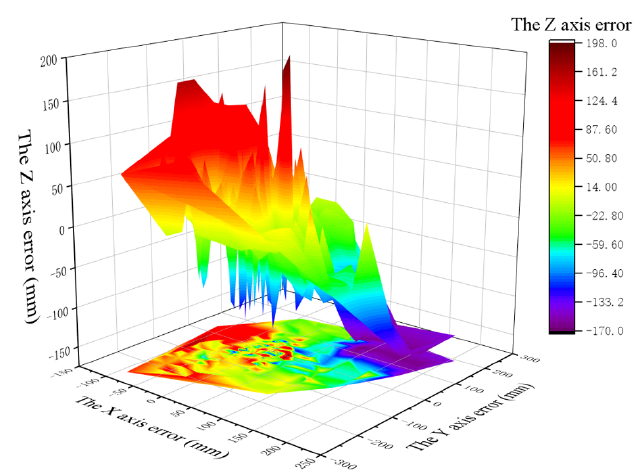
Figure 14. 3D ( X , Y , Z ) accuracy of abnormal data sets based on C-T-CNN-SVM algorithm.